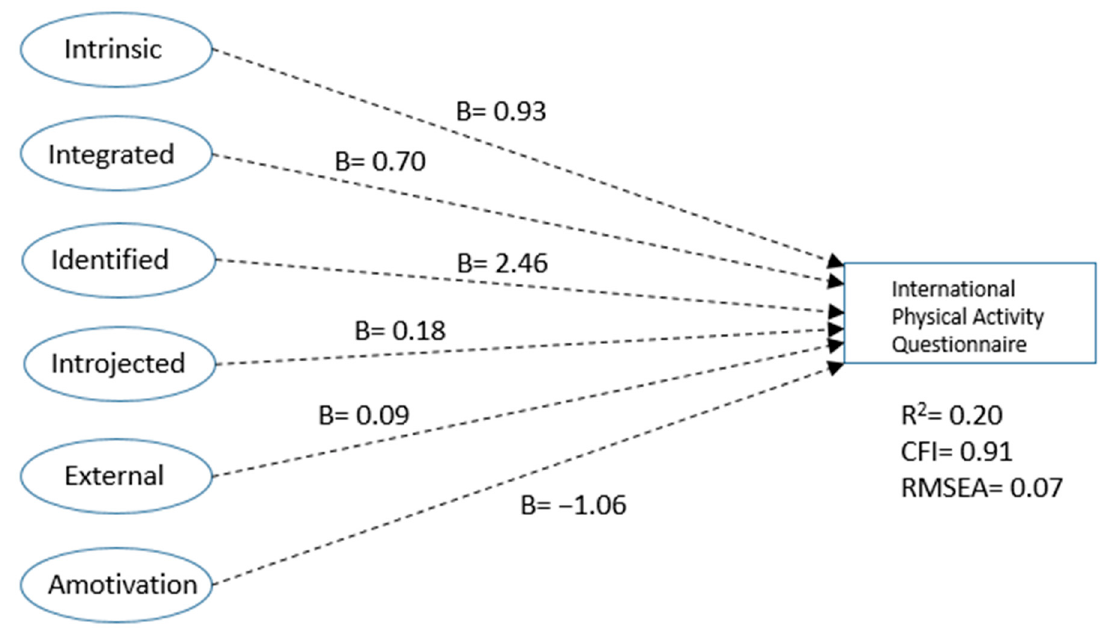
Figure 1. Unstandardized regression coefficients for Self-Determination Theory (SDT).